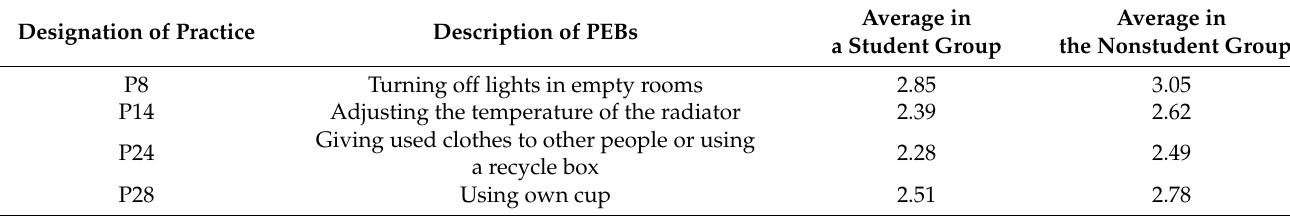
Table 4. Statistically significant (at the p < 0.05 level) results of the Mann–Whitney test with a grouping variable— involvement in the educational